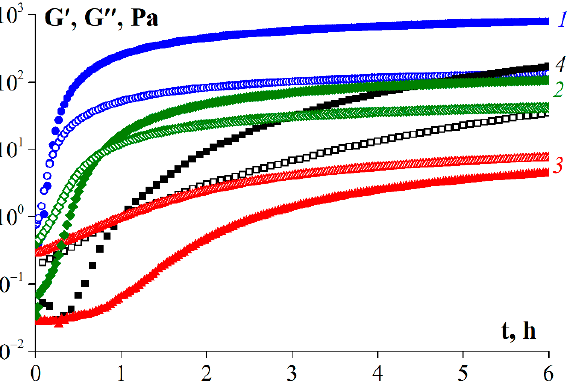
Figure 7. Gelation kinetics of gelatin samples: 1—G1, 2—G2, 3—G3, 4—G 7041. T = 6 °C, ω = 6.28 rad/s, γ = 1%. Gelatin concentration was 10 wt.%. The initial temperature of the samples was 25 °C.